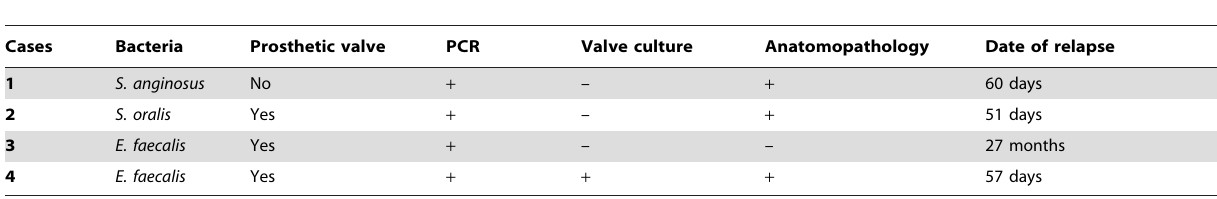
Table 3. Relapses after medical